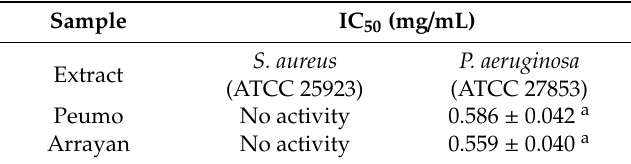
Table 4. Disruption of mature biofilm.